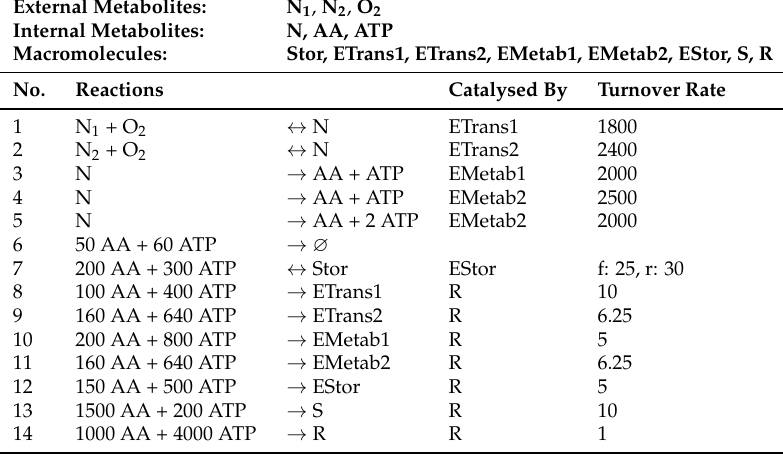
Table 3. List of species, reactions, and catalysis relationships for the toy model whose SBML representation can be found in the Supplement. Reaction 6 is the maintenance reaction and is considered spontaneous. Reaction 7 has different turnover rates for the forward (f) and reverse (r)